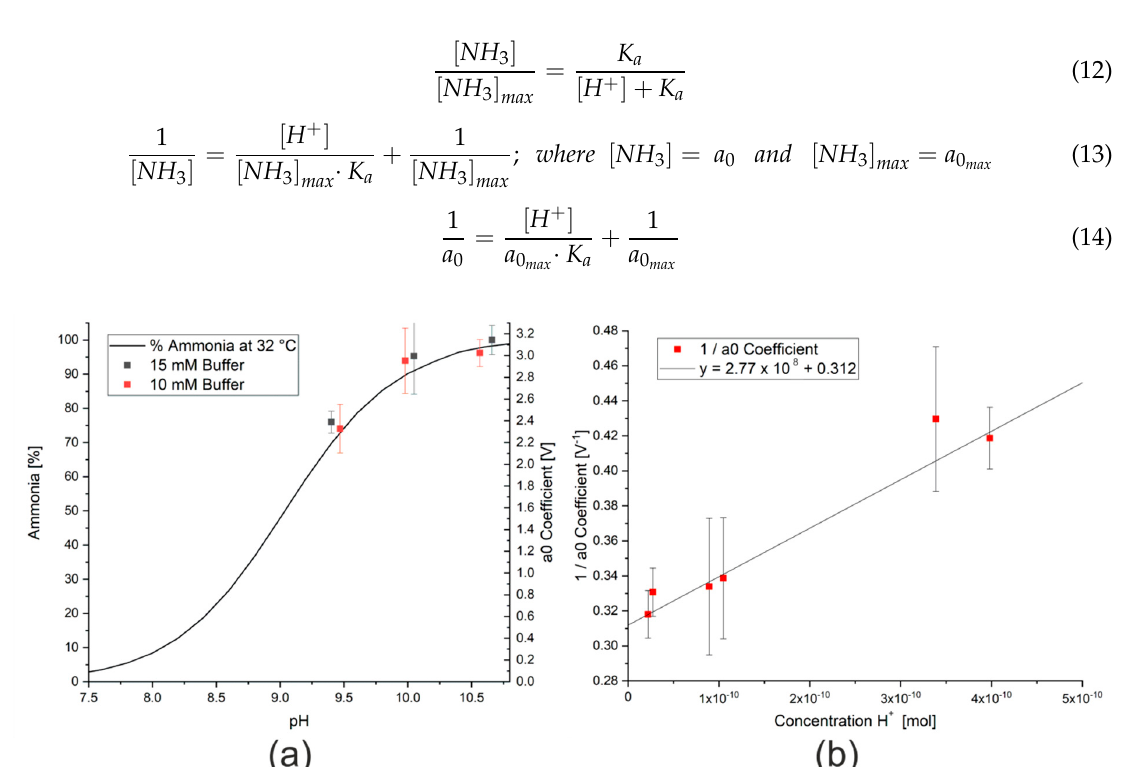
Figure 6. ( a ) Effect of changing pH on percentage of ammonia present in a solution of ammonia molecules and ammonium ions from literature data [36] and data from this study. ( b ) Inverse of a 0 coefficient measured for a 62 ppm ammonia solution in the presence of different buffer solutions.